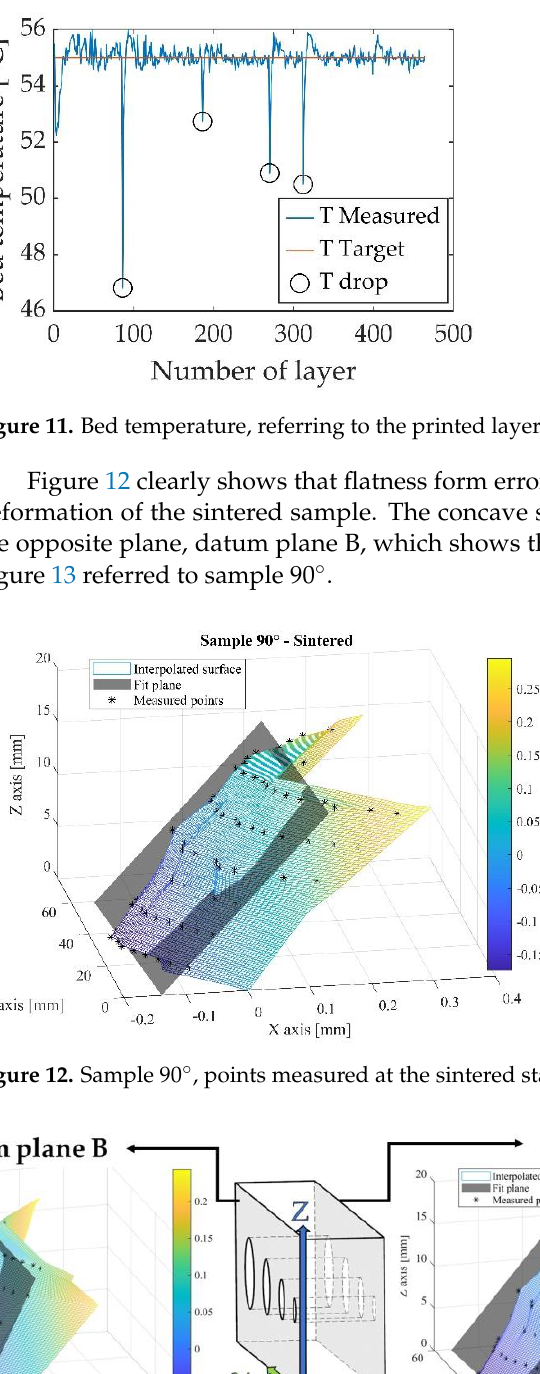
Figure 11. Bed temperature, referring to the printed layer.